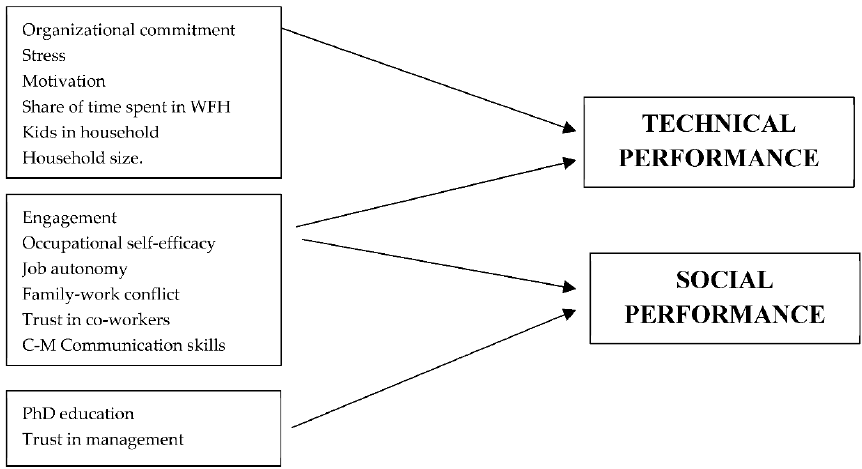
Figure 5. The influence of the WFH factors on social and technical performance.